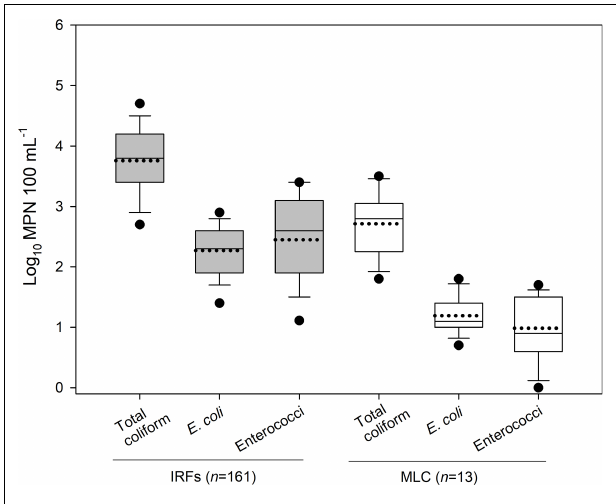
FIGURE 1 | The level (log 10 MPN 100 mL - 1 ) of total coliform, E. coli , and enterococci in the irrigation return flows (IRFs) and background canal site (MLC) in the Upper Snake Rock watershed in south-central Idaho. The black horizontal lines in the box plots, from bottom to top including the whisker caps, represent the 10th, 25th, 50th, 75th, and 90th percentiles, while the black dotted line is the mean and black circles are the 5th and 95th percentiles.